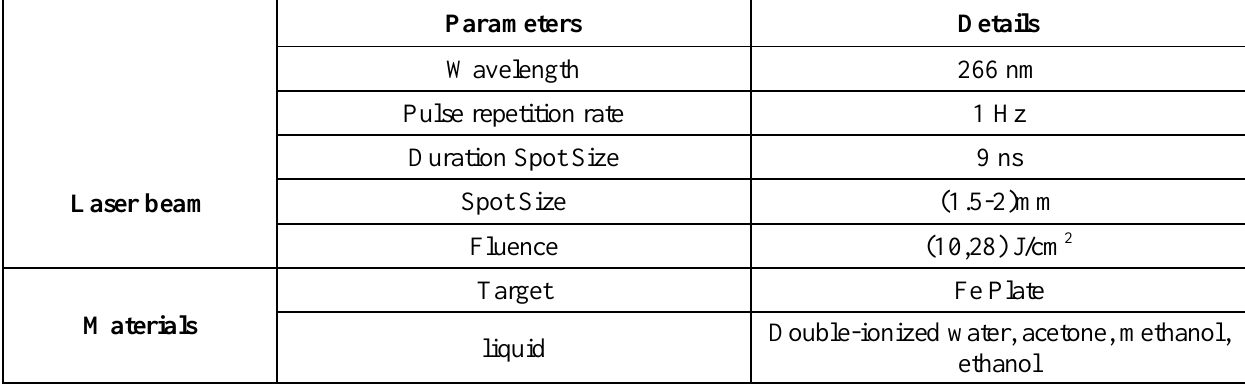
Table 1 : Laser parameters and materials used in the experimental setup for prepared